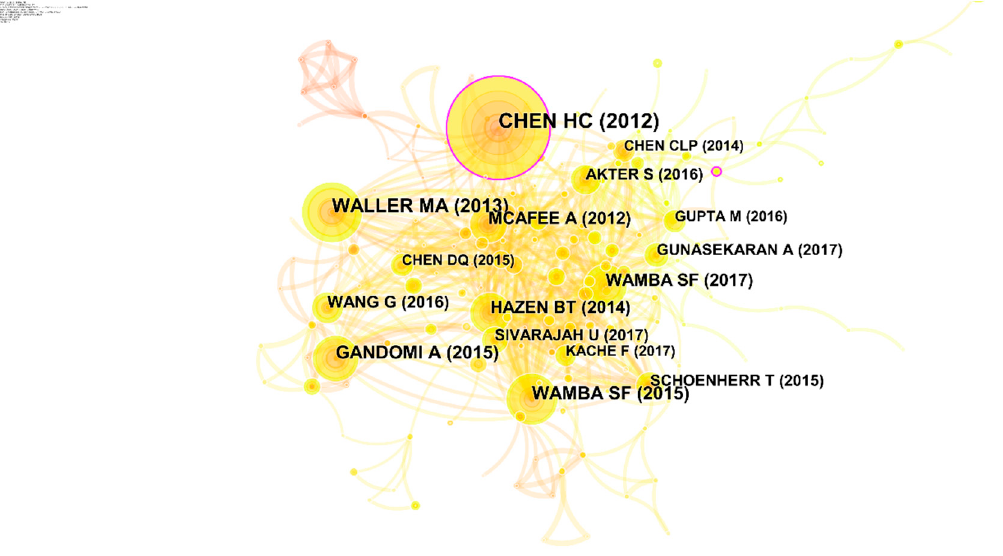
Figure 4. The distribution of cited journals (The yellow links represent citation relationship between journals). Table 3. The top 5 co-cited journals according to centrality.